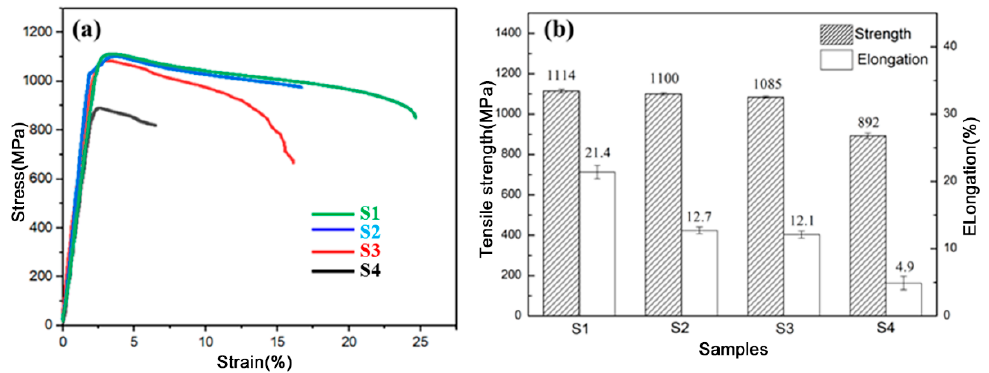
Figure 11. ( a ) Stress–strain curves of SLM-processed Ti-22Al-25Nb samples at di ff erent scanning speeds, ( b ) variations in average tensile strength and elongation with scanning speed.